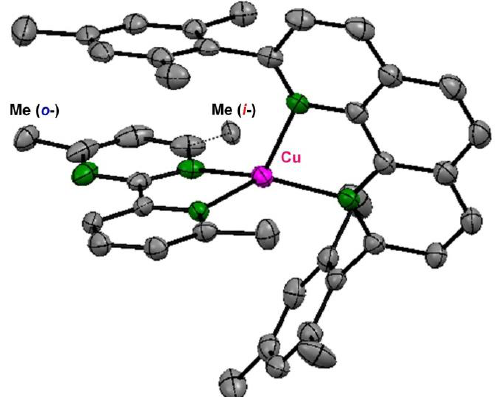
Figure 4. ORTEP drawing of 1  BF 50% probability level. Hydrogen atoms, counter anions, crystal solvents, and one of the two crystallographically independent complex cations are omitted for clarity. Adapted with permission from [42]. Copyright (2012) American Chemical